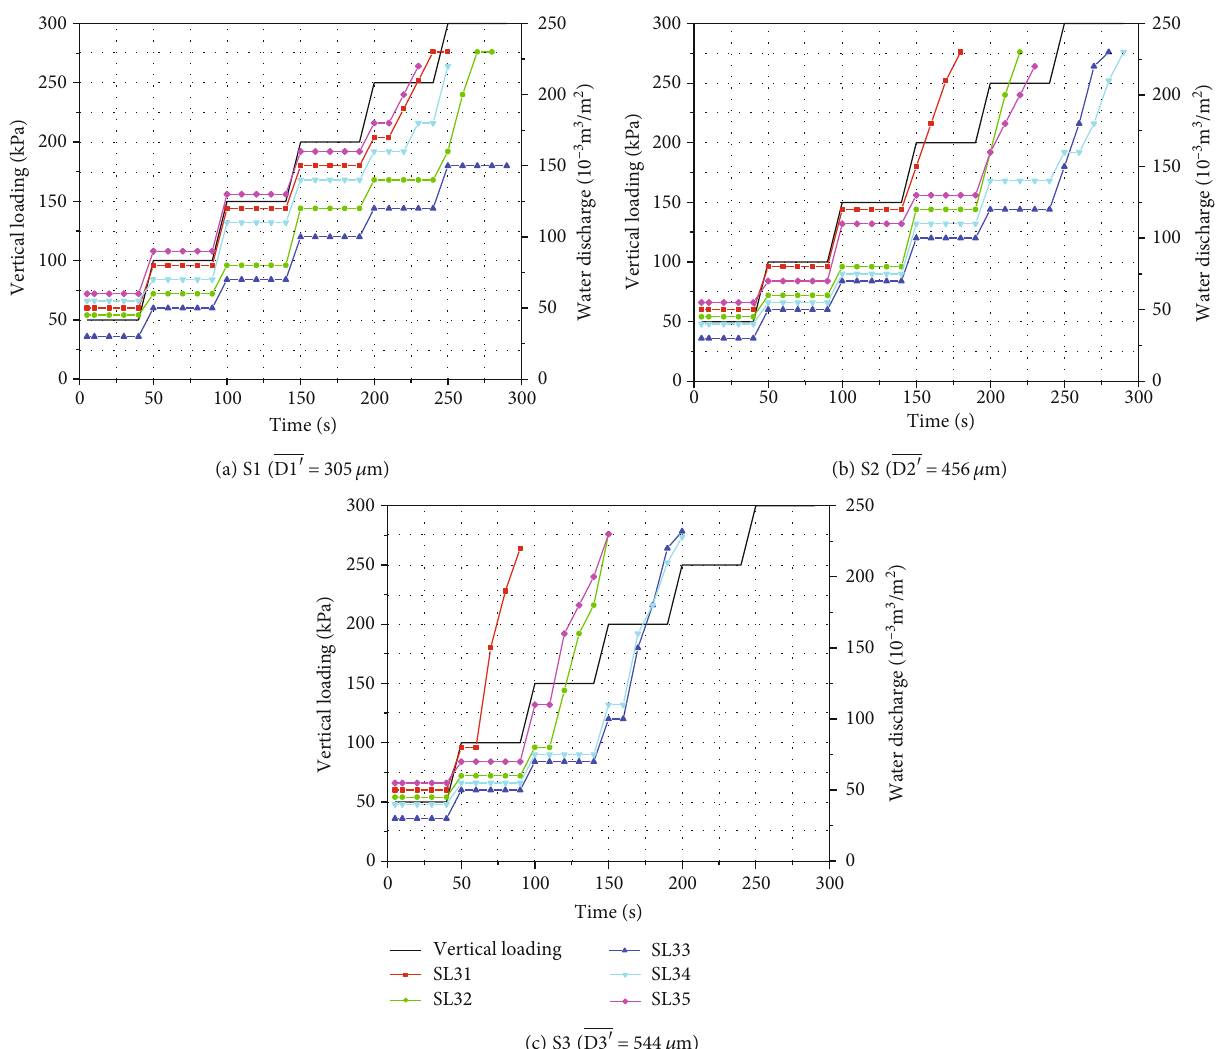
Figure 3: Pressure gradient and in fi ltration curve of the